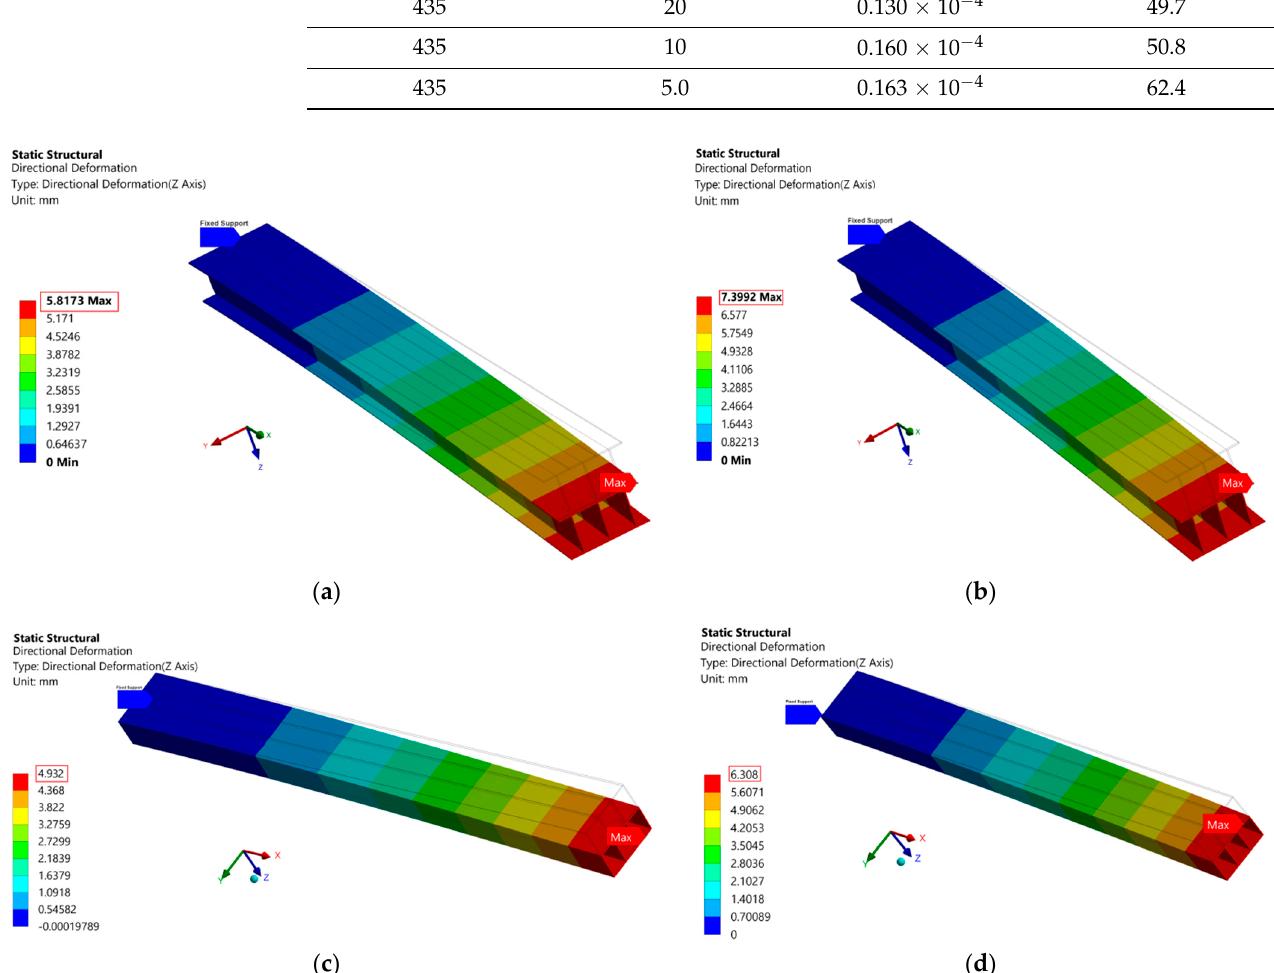
Figure A4. Static loading deflection of the CFRP beam related to Section 5 for ( a ) “III” section and “L2” layup, ( b ) “III” section and “L8” layup, ( c ) “SSS” section and “L2” layup, and ( d ) “SSS” section and “L8” layup.